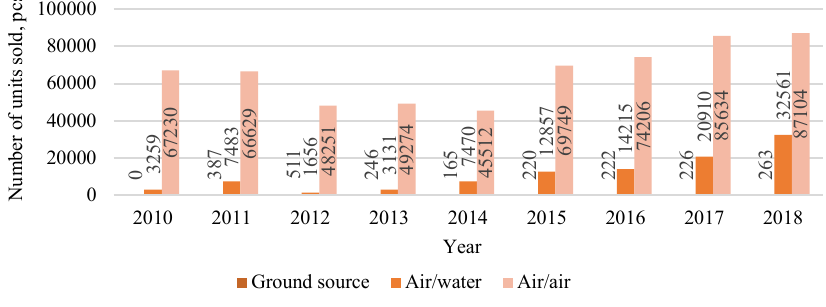
Fig. 8. The number of heat pumps sold in Spain by